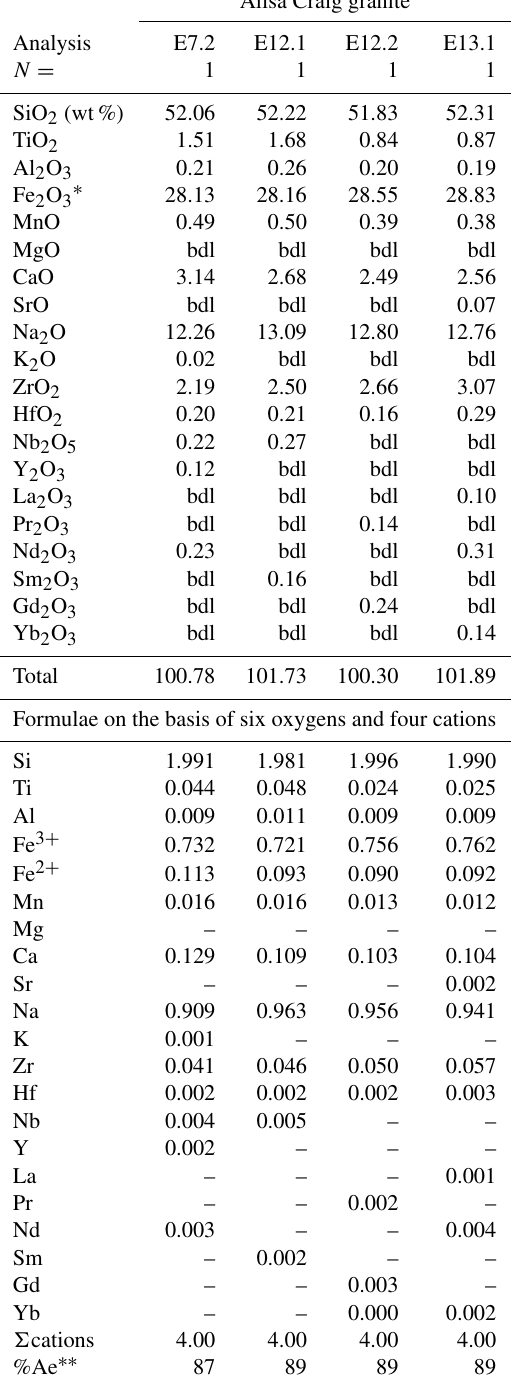
Table 14. Compositions of Zr-bearing